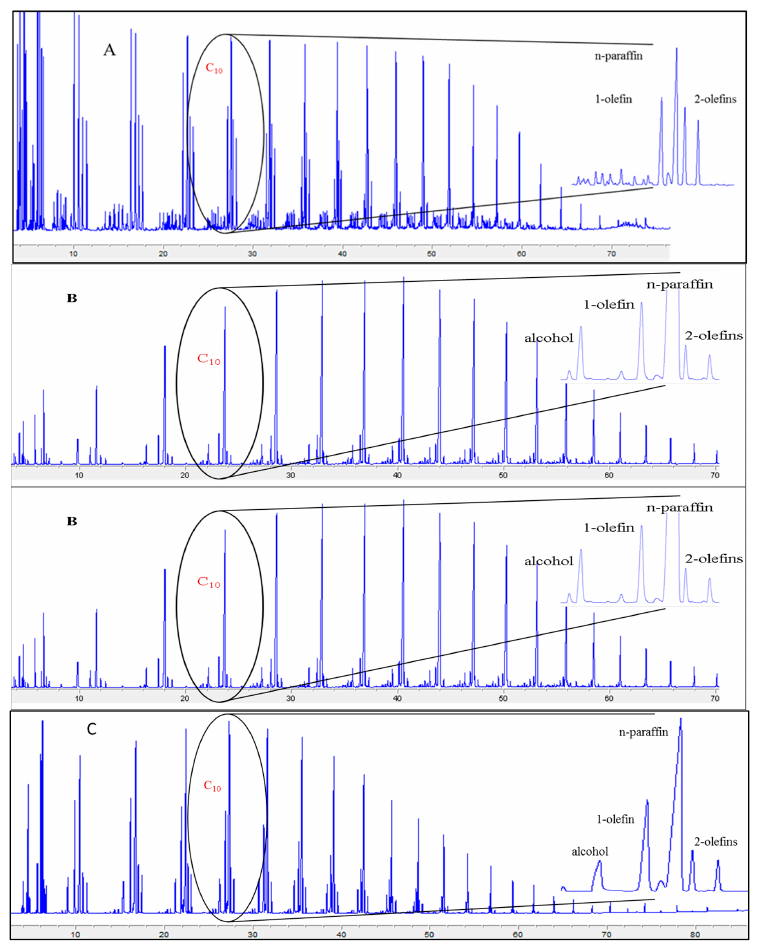
Figure 8. Typical flame ionization detector (FID) chromatographs for the products of the oil phase for Fe-Cu/SiO 2, 270 °C, 12.1 bar, WHSV = 2, H 2 /CO = 0.7 ( A ), 0.5%Pt/25%Co/Al 2 O 3 , Temperature 225 °C, Pressure = 27.6 bar, WHSV = 8, H 2 /CO = 2 ( B ); and, 1%Ru/Al 2 O 3 , Temperature 241 °C, Pressure = 19.2 bar, WHSV = 1.5, H 2 /CO = 2 ( C ) FTS catalysts.